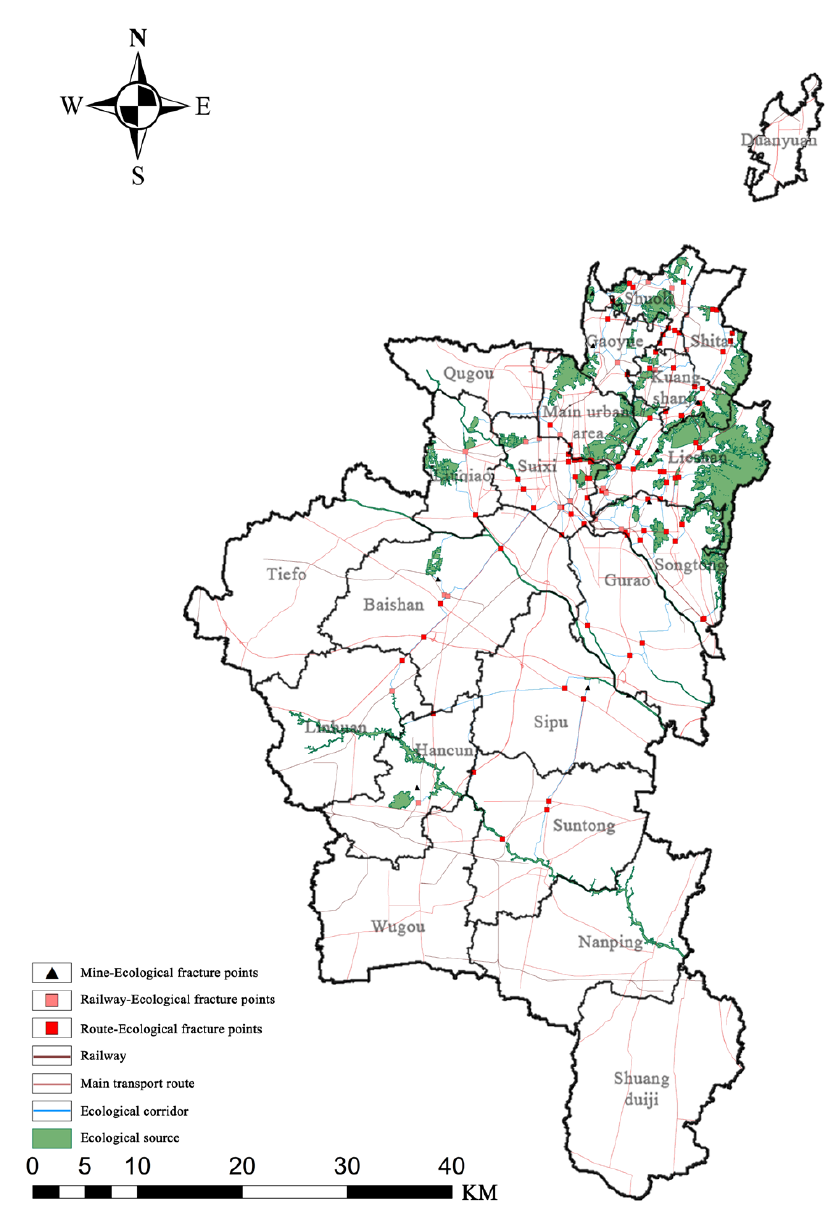
Figure 13. Ecological fracture points in Huaibei City. Table 6. Distribution of ecological fracture points in Huaibei City.